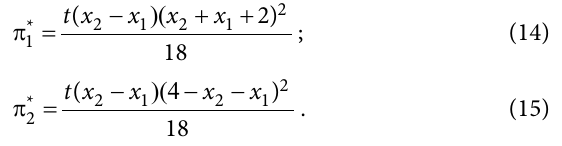
Table 1. Strategy combinations of building developers’ game Developer